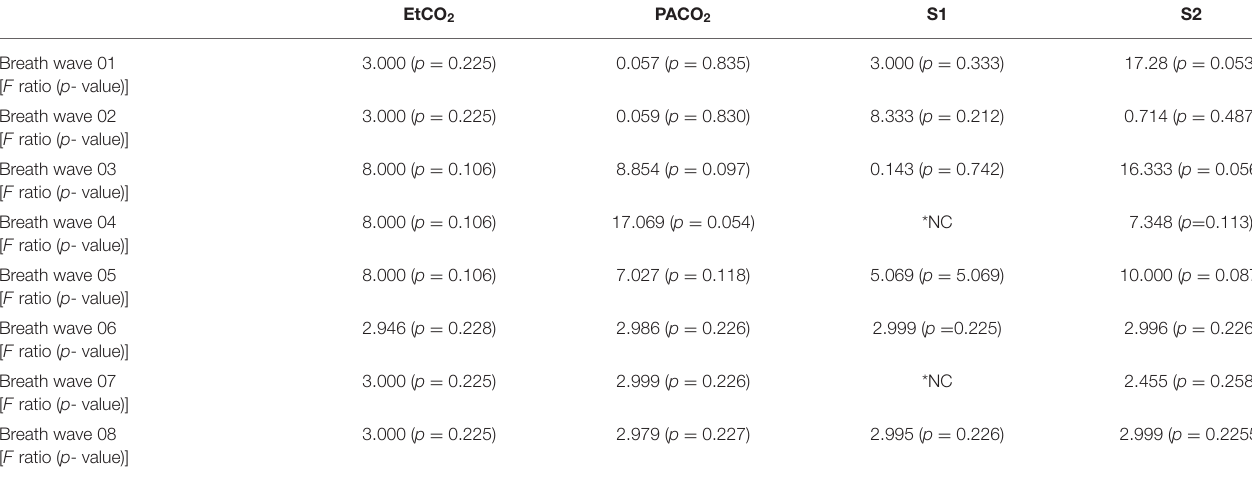
TABLE 2 | The S2S1Sr, VtCO 2 , alpha angle, and ETIR analysis.